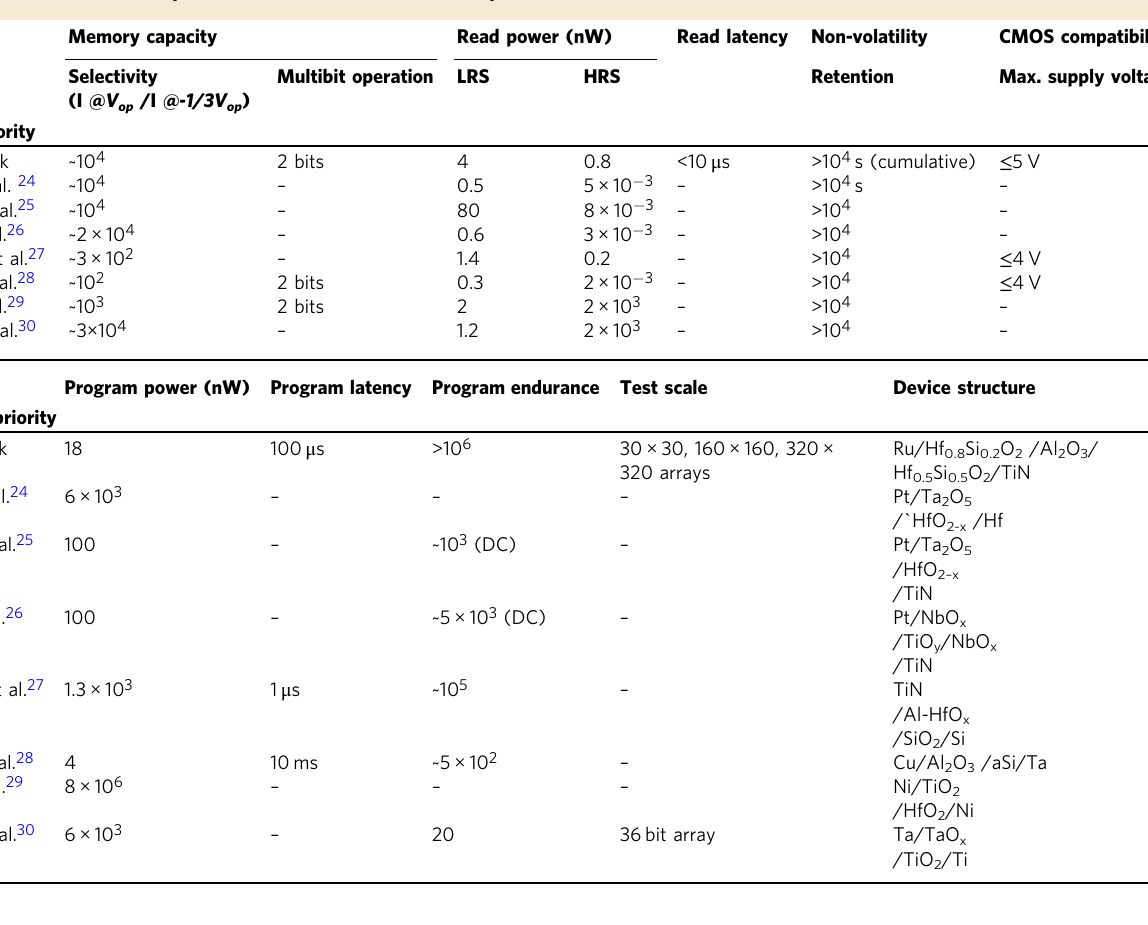
Fig. 1b indicate the onset of set switching at a positive voltage and a gradual reset behavior with the increase in reset voltage